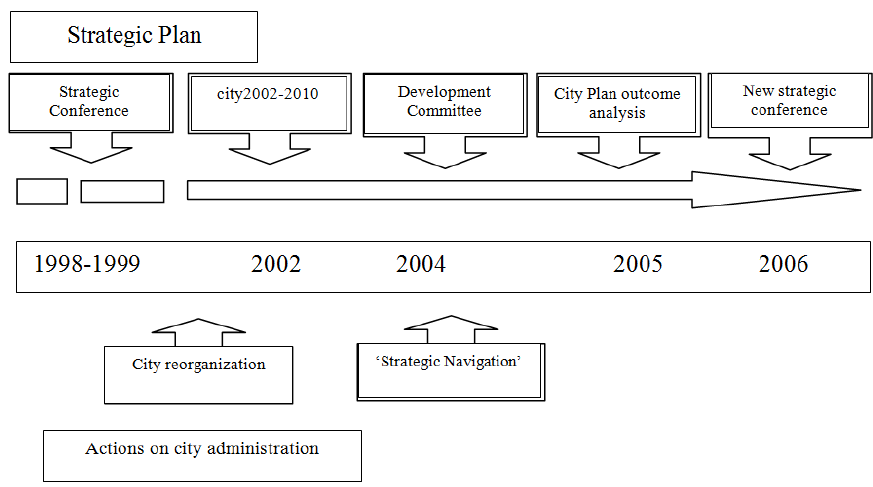
Figure 1: The Strategic Planning Process and Connection with Organisational Change Within the